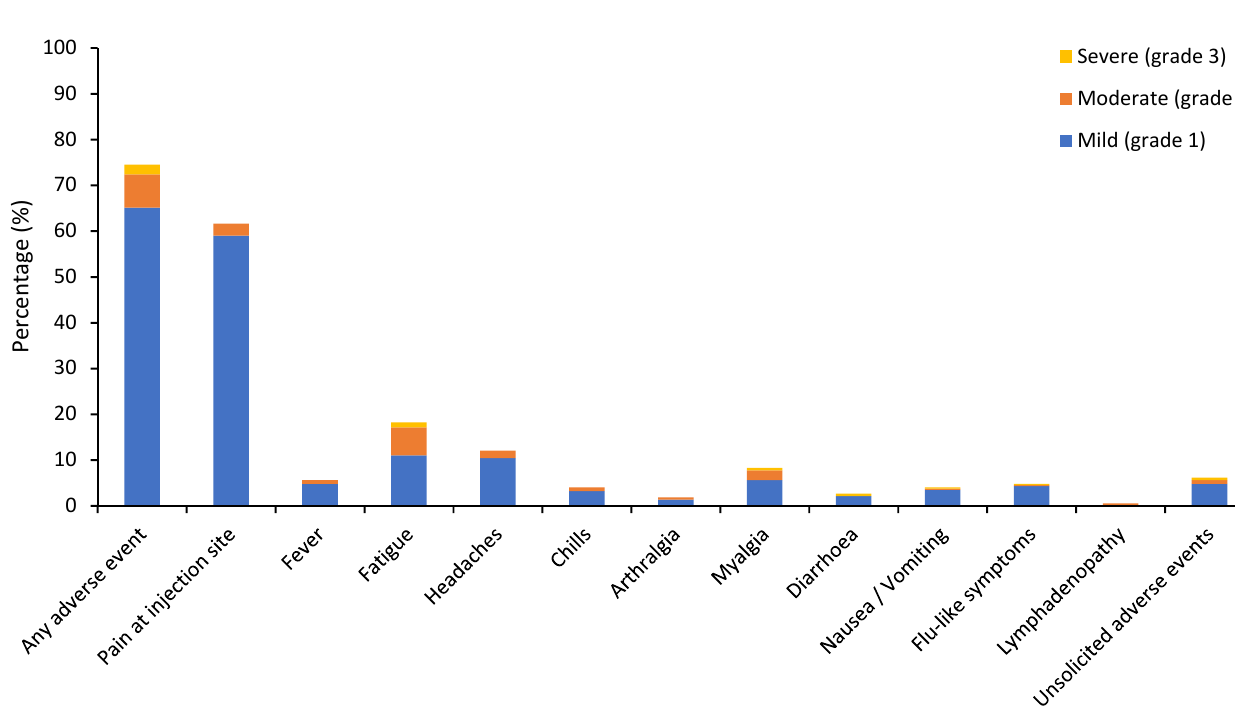
Figure 1. Vaccine-related adverse events within 7 days post-vaccination.